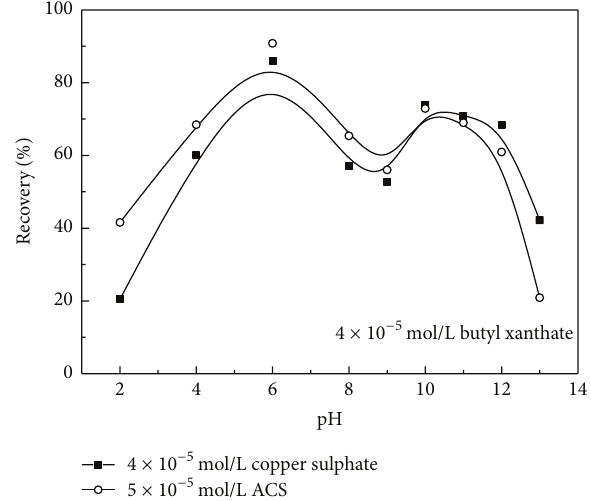
Figure 5: Effects of pH on sphalerite recovery (sulphuric acid and sodium hydroxide solution as pH